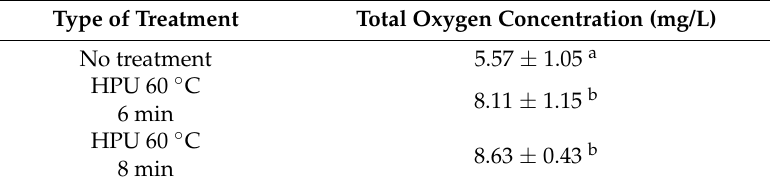
Figure 6. Influence of HPU treatment on O 2 desorption. Table 2. Total oxygen desorption for different type of treatment over 26 days. The total oxygen concentration is the sum of each mean oxygen value during each 6-day period previously shown in Figure 6.